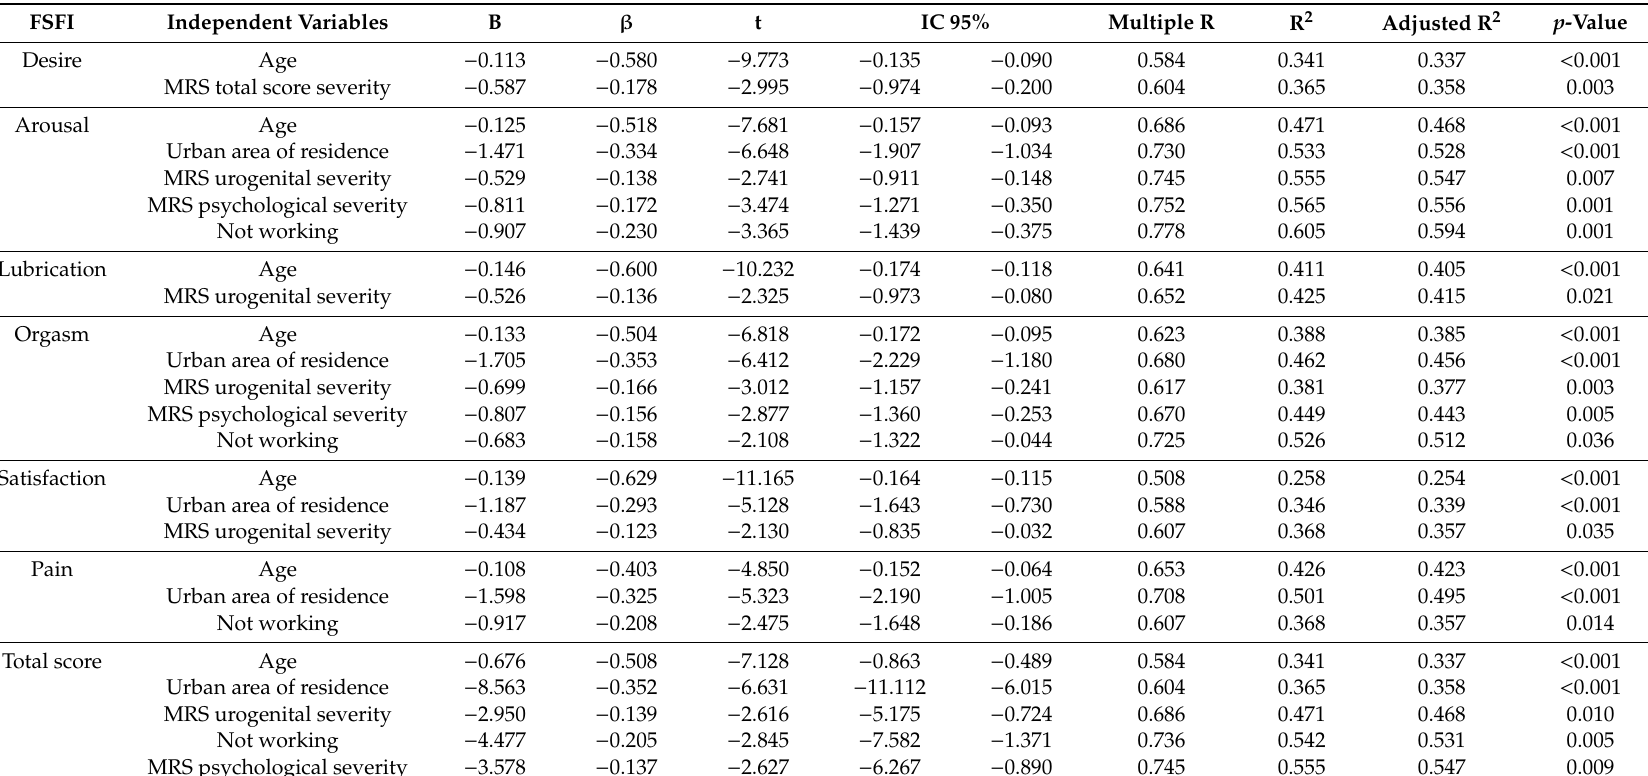
Table 4. Multivariate linear regression analyses for variables associated with FSFI scores ( n =